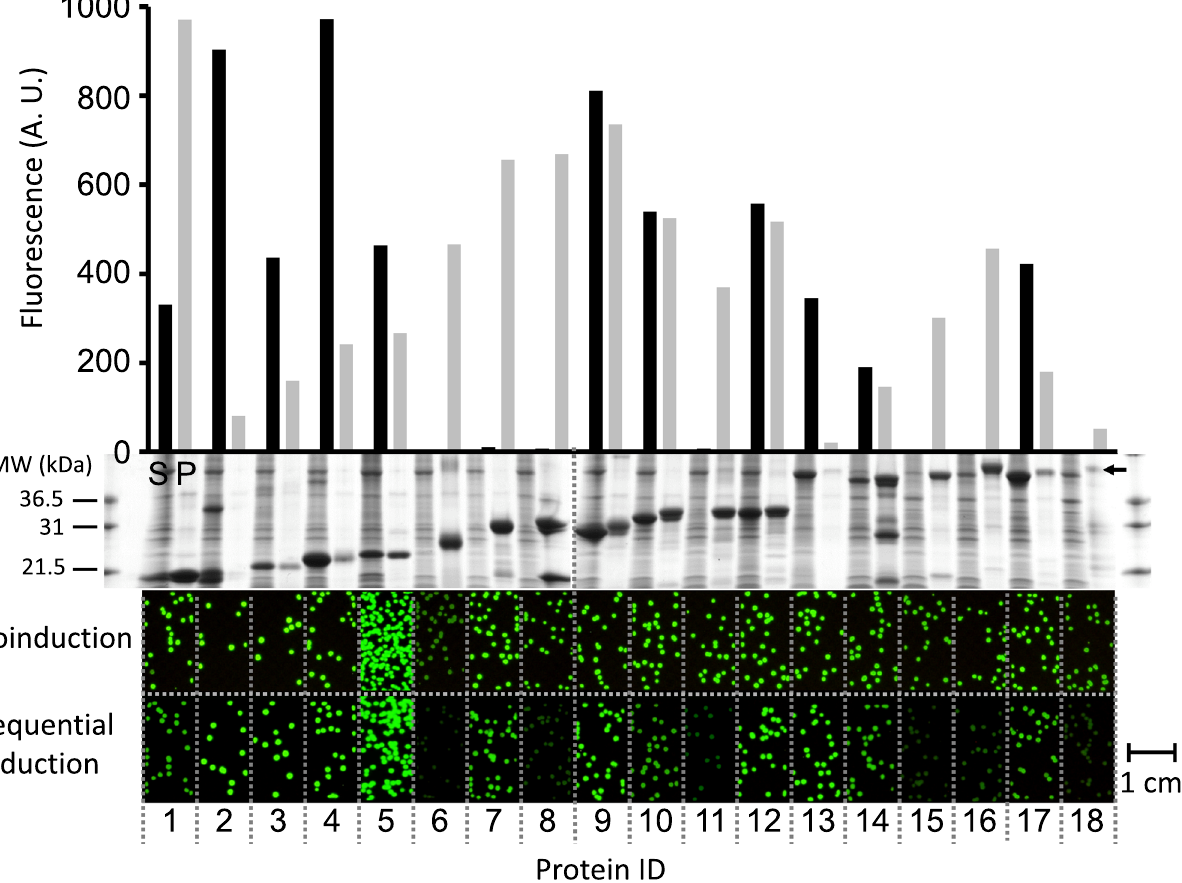
Figure 4. In vitro protein quantification and in vivo protein expression and solubility screens in E. coli . Protein quantification of eighteen P. aerophilum test proteins (see Supplementary Table S1) expressed as N-terminal fusions with ccGFP S11 v1 from the strong T7 promoter (bar graph, top). The ccGFP fragment complementation assay fluorescence of soluble (black bars) and unfolded pellet fractions (gray bars) using ccGFP 1–10 v2 (top). Arbitrary fluorescence units (A. U.). SDS-PAGE of the corresponding soluble (S), and pellet fractions (P) (middle). Note that protein #8, tartrate dehydratase β -subunit, shows a second lower band at ~ 13 kDa. #14, nirD protein, shows secondary bands at ~ 27 kDa and ~ 13 kDa. Original pictures of the 2 SDS- PAGE gels showing the soluble and pellet fractions of 18 test proteins are included as Supplementary Figs. S9, S10. In vivo solubility and expression screen using split ccGFP (lower). The same P. aerophilum test proteins cloned with a C-terminal ccGFP S11 v1 tag on tet promoter plasmid, in E. coli BL21 (DE3) strain carrying a pET plasmid for expression of ccGFP 1–10 v2. Fluorescence images of colonies on plates after total expression screen by coinduction of the tagged constructs and ccGFP 1–10 v2 (upper row of colonies); or after soluble expression screen by transient expression of the tagged constructs followed by expression of the ccGFP 1–10 v2 (lower row of colonies). Fluorescence images of colonies were cropped from the same pictures. Note 1 cm scale bar (lower right) illustrating the size of the